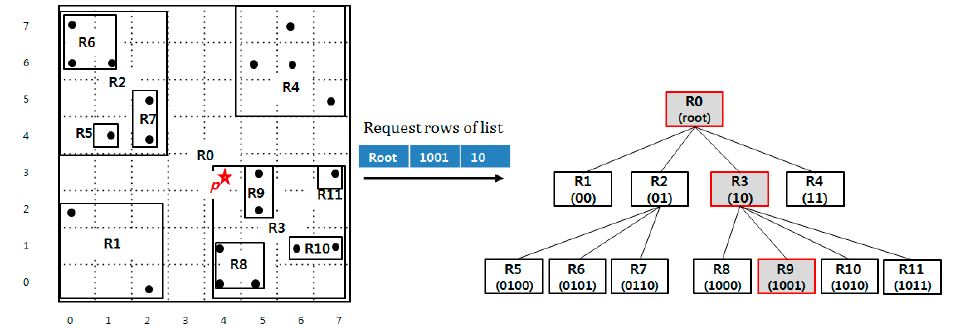
Figure 8. Example insertion operation.